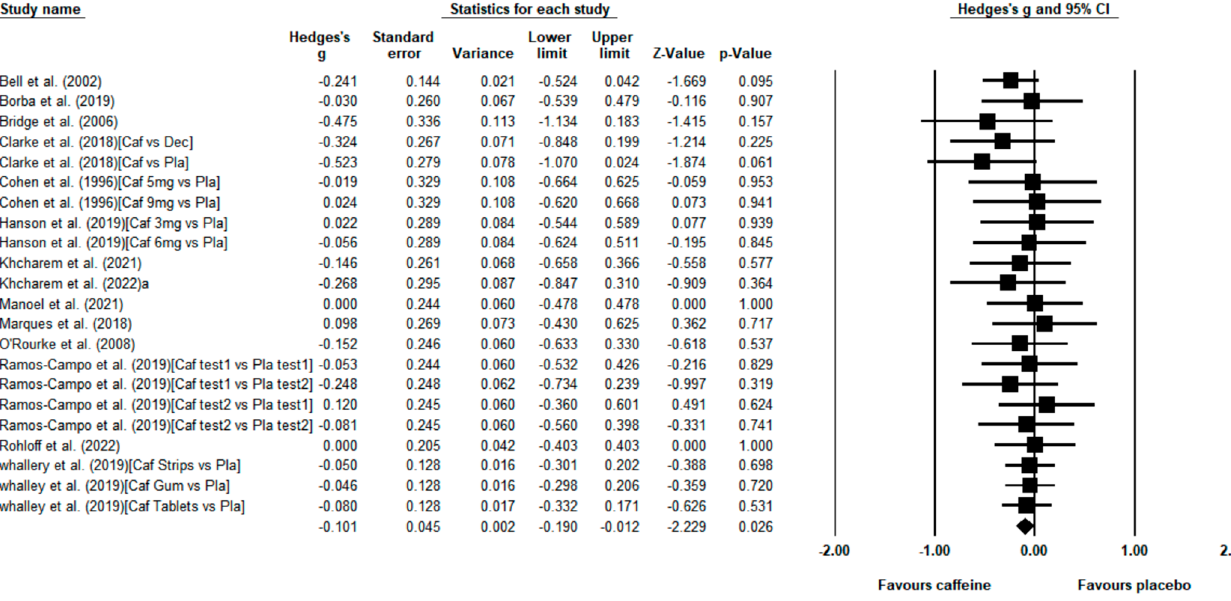
Figure 4. Effect of caffeine ingestion as compared to placebo on endurance running time trials. The forest plot shows standardized mean differences with 95% confidence intervals (CI) for 22 unique placebo–caffeine comparisons in 14 studies [7,23–26,30,34,35,42,48,50,52–54]. The diamond at the bottom of the graph represents the pooled standardized mean difference following random effects meta-analyses. A negative value reflects a reduction in the time employed to complete a given distance with caffeine with respect to the placebo. The size of the plotted squares reflects the relative statistical weight of each study. Caf, caffeine; Dec, decaffeinated coffee; Pla, placebo. Table 3. Subgroup analysis by training status and distance on the effect of the caffeine ingestion on endurance running time trials.